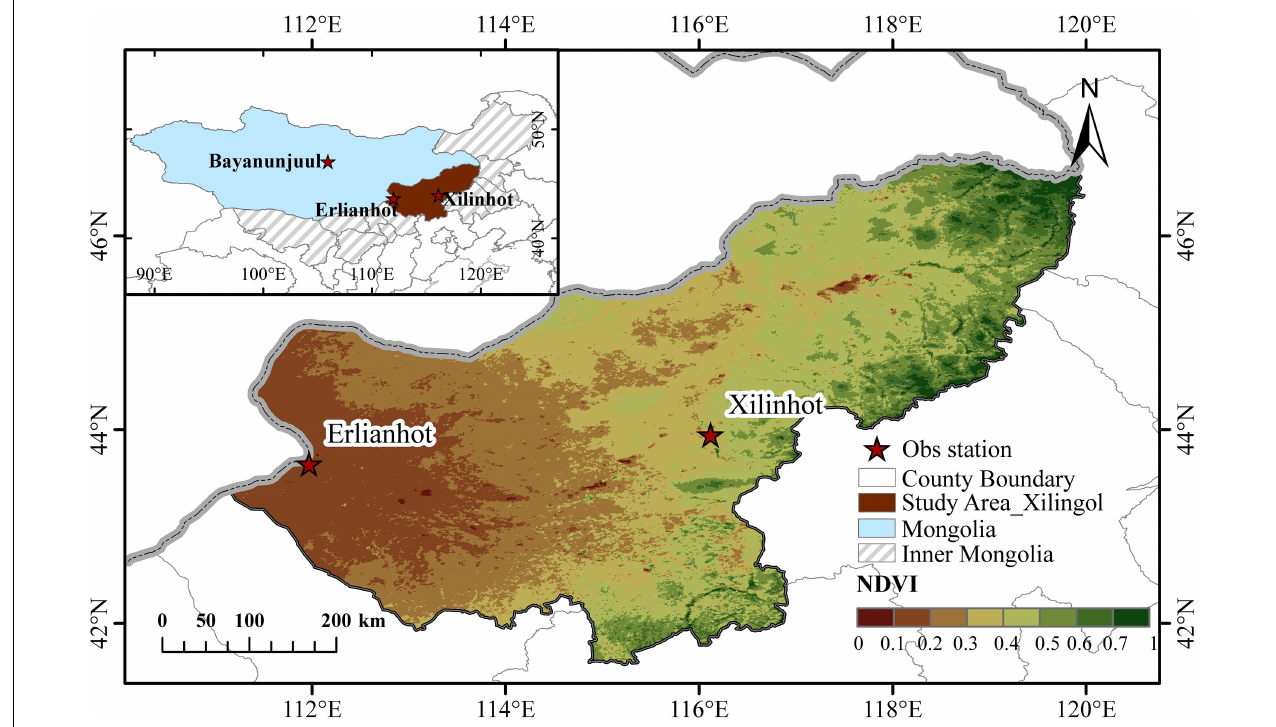
FIGURE 1 | Yearly maximum vegetation condition (2000–2016) across study area of Inner Mongolia by the annual maximum (at the end of August) normalized difference vegetation index (NDVI).